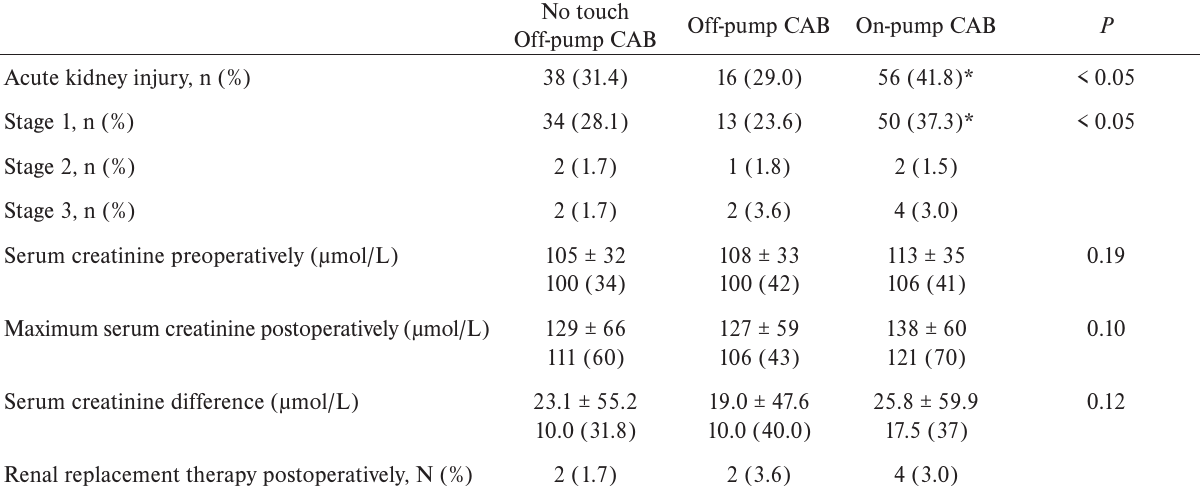
Table 2. Renal data in the single groups. The results are presented as the numbers of patients and relative frequency, or as the means with standard deviations and medians with